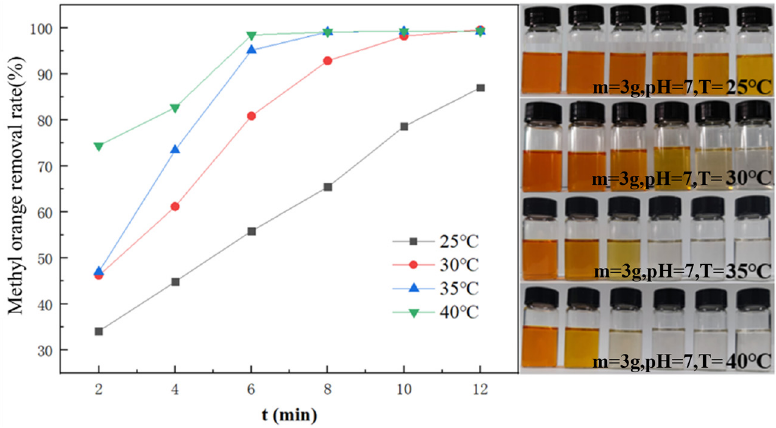
Figure 15. In fl uence of treatment temperature on the removal of methyl orange. Figure 15. Influence of treatment temperature on the removal of methyl